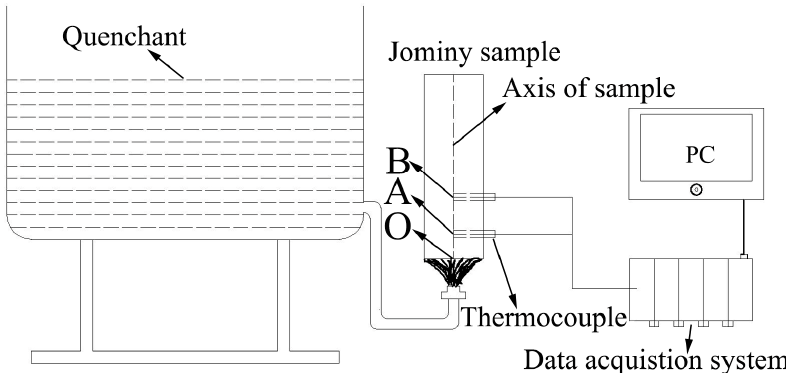
Figure 2. Schematic diagram of Jominy end-quench test .